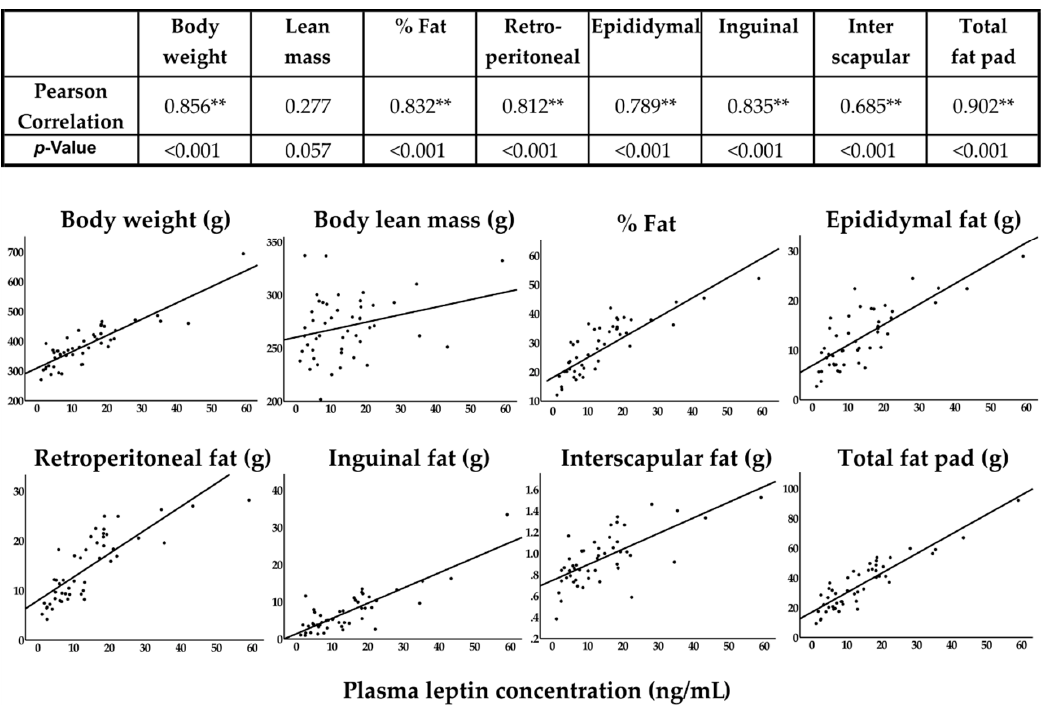
Figure 1. Correlation of plasma leptin with body composition and fat pads was evaluated by the Pearson correlation method. Asterisks indicate a significant difference. “Total fat pads” is the summation of retroperitoneal, epididymal, inguinal, and interscapular fat pad. Scatter plot charts represent the correlation of plasma leptin with each individual parameter.